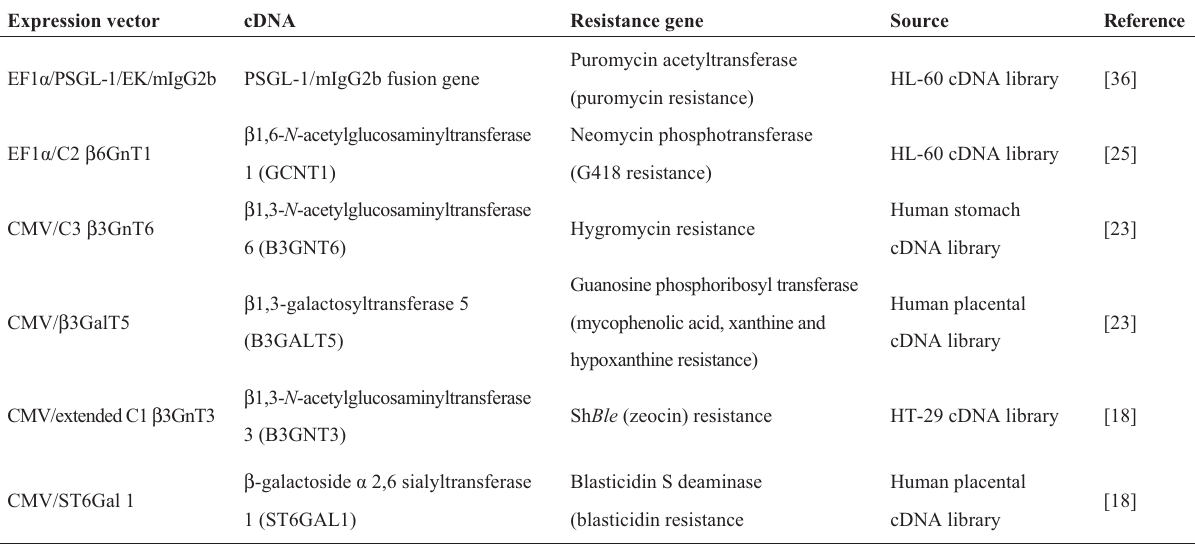
Table 2. Expression vectors used in this